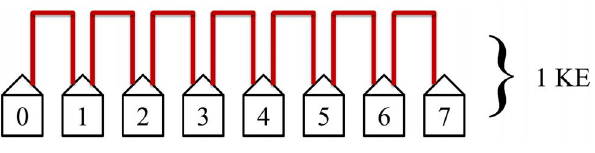
Figure 7. The first step in the protocol connects the nearest neighbors. This step is the quickest and most efficient. It has the most non-overlapping simultaneous loops and requires only 1 KE to complete. Every host in this step has access to KLJN band and thus are in State 2.